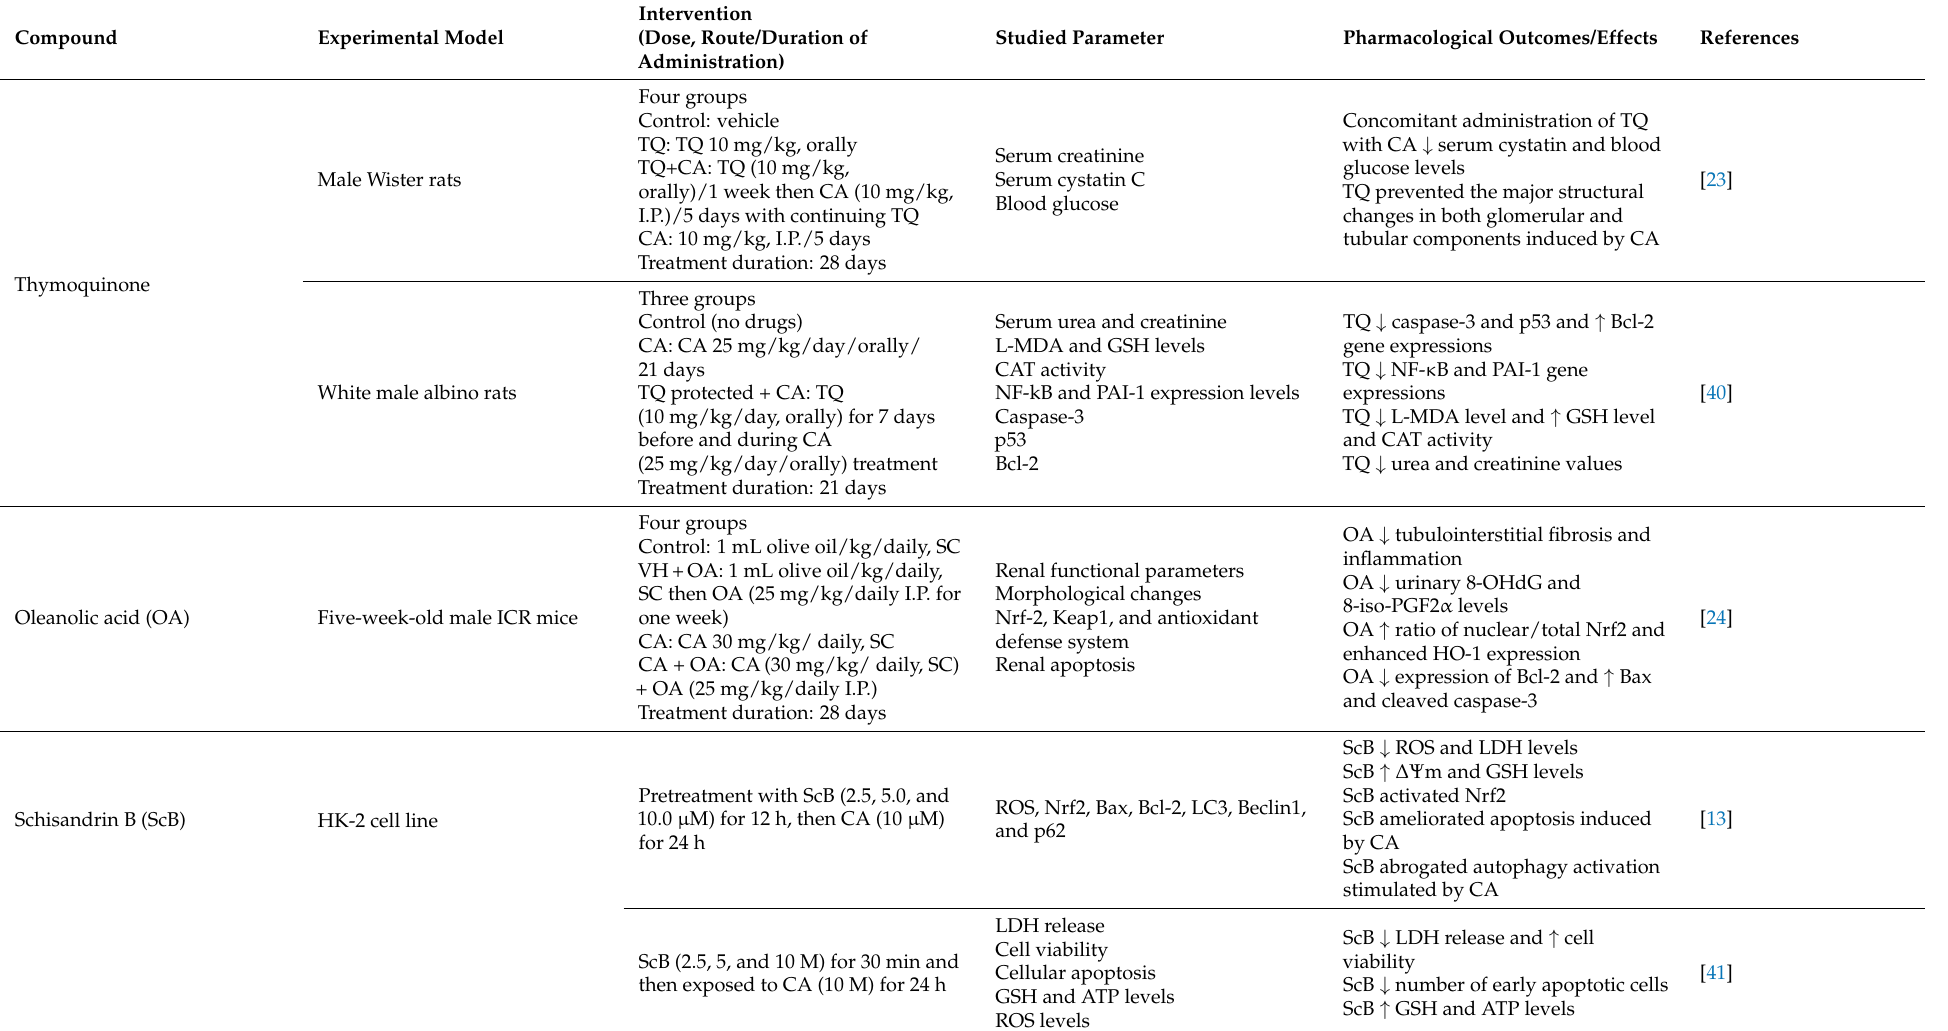
Table 2. Protective effects of natural compounds on CA-induced renal